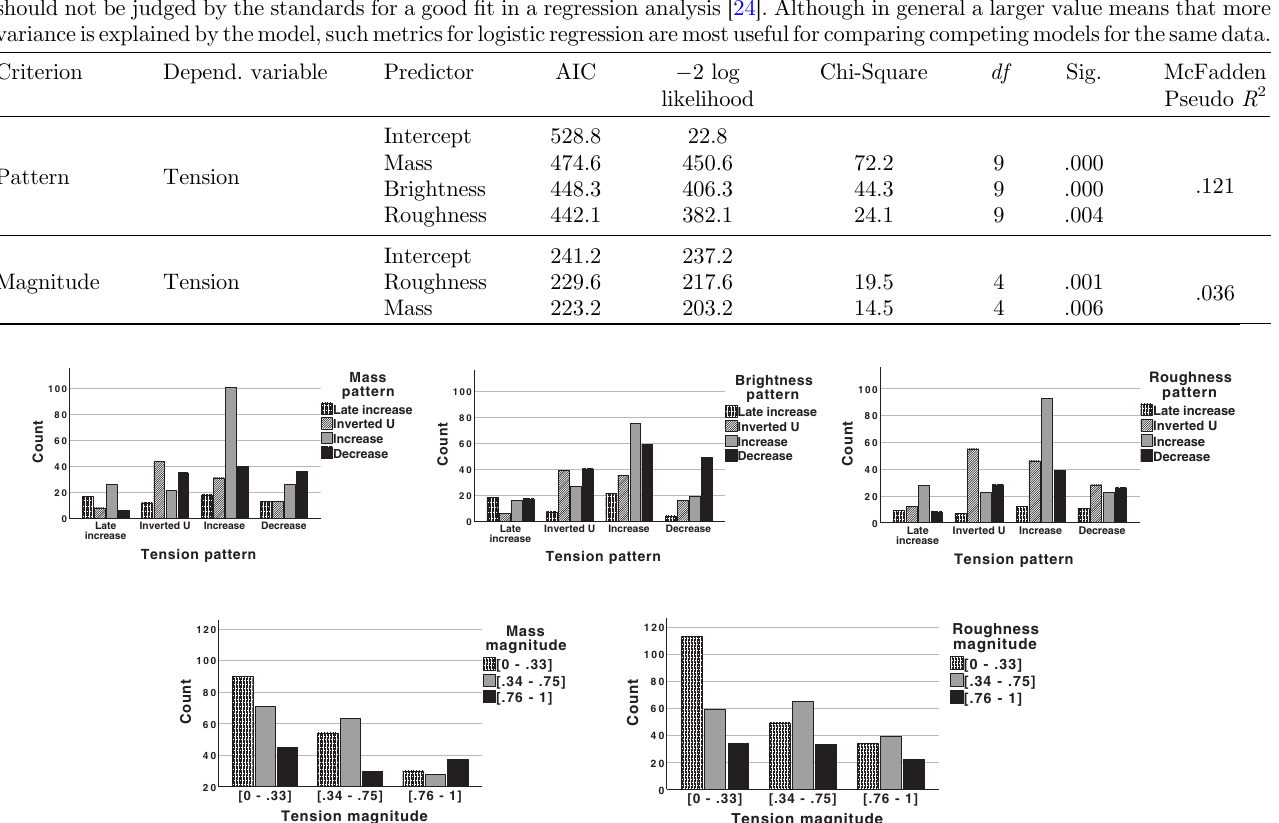
Figure 5. Frequencies of occurrences for tension patterns (top) and tension magnitudes (bottom) within the corresponding categories of the signi fi cant predictors.